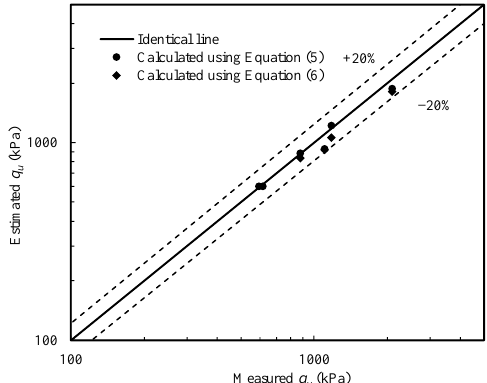
Figure 9. Comparison between measured and calculated bearing capacities.